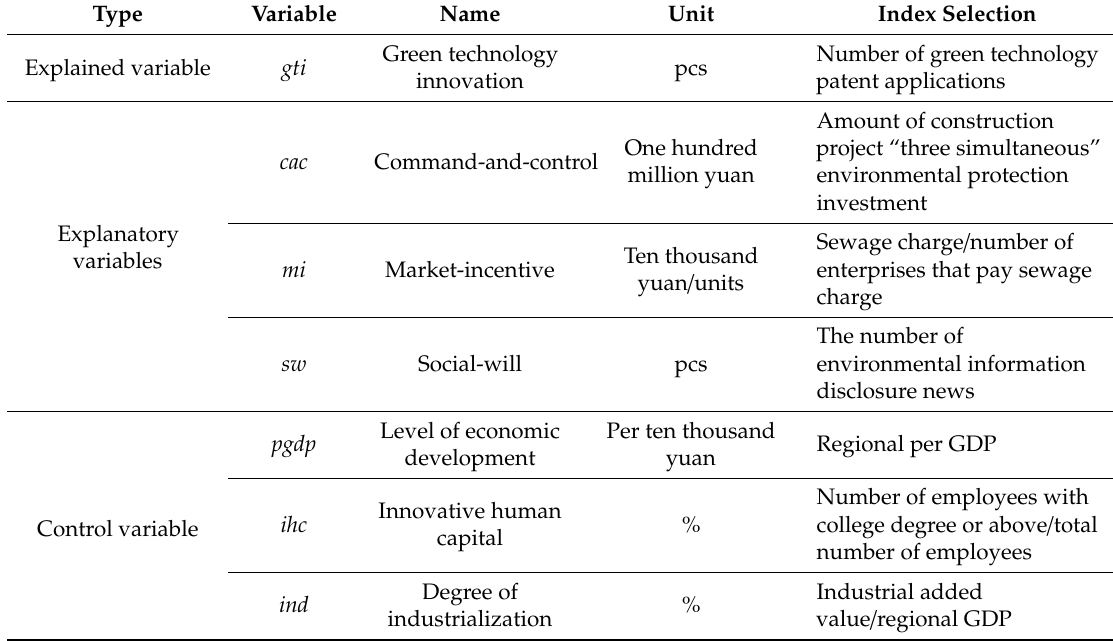
Table 1. The selection results of variable